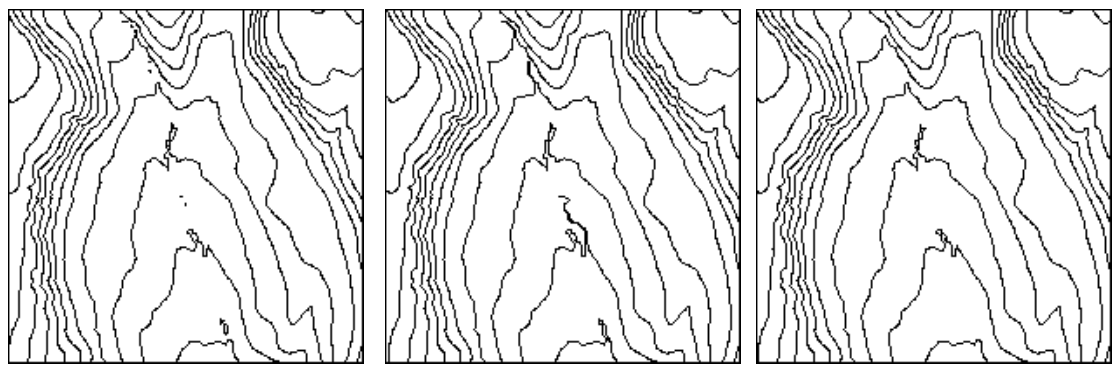
Figure 5. Relief with contour lines, Papuk DTM5 (left - a), after the pit removal by carving method (middle - b) and after the pit removal by filling method (right -